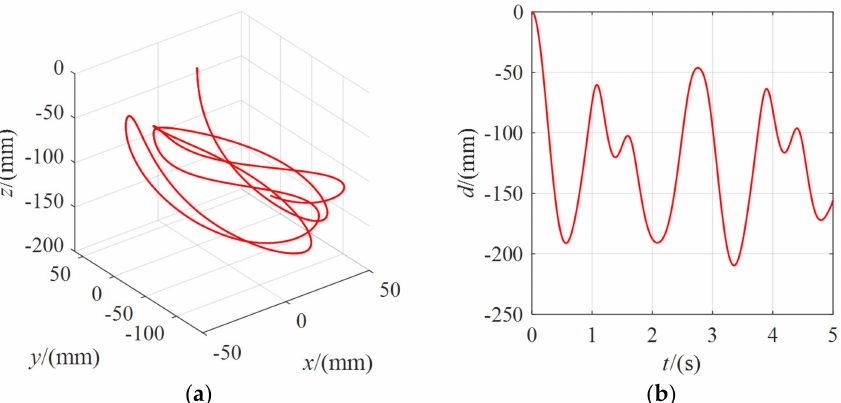
Figure 13. The position change of the moving platform under the external force of 5 N for λ = 80: ( a ) the coordinate curve of the moving platform center point in the spatial coordinate system O-xyz ; ( b ) the variation curve of the linear distance between the center point of the moving platform and the initial pose.